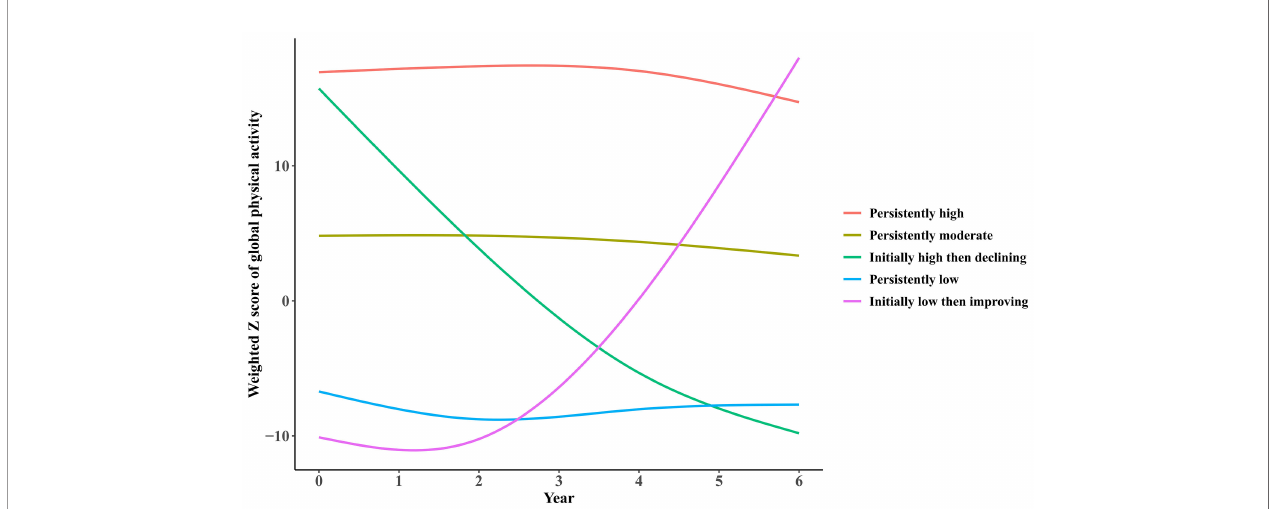
FIGURE 2 | Trajectories of participation in global physical activities by participants from the ELSA over a 6-year span.